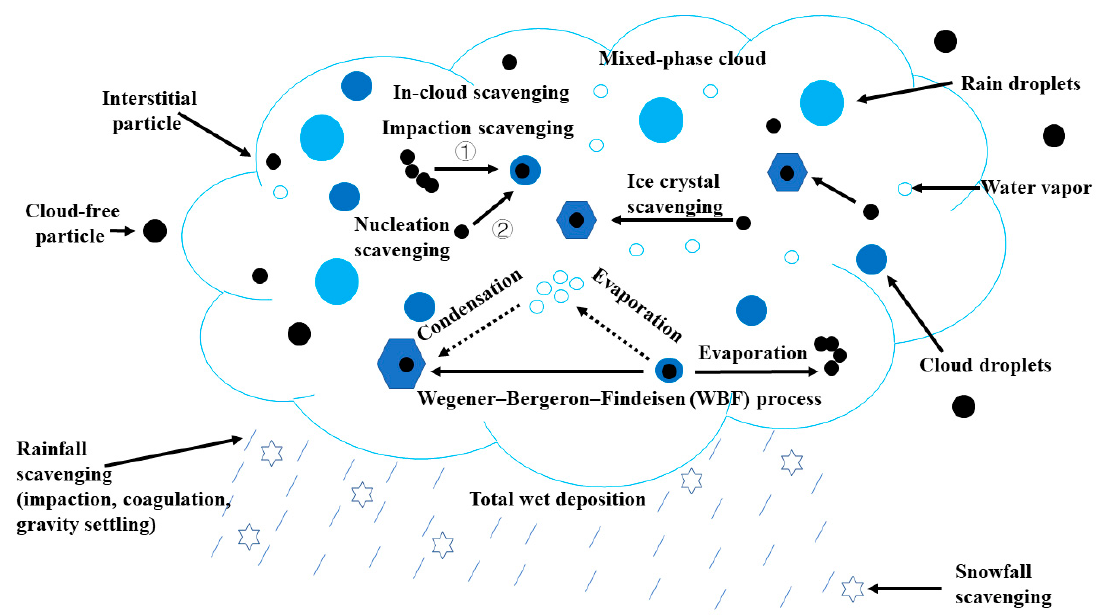
Figure 1. Main processes of wet scavenging of black carbon (BC) (adapted from Hoose et al. [51]).